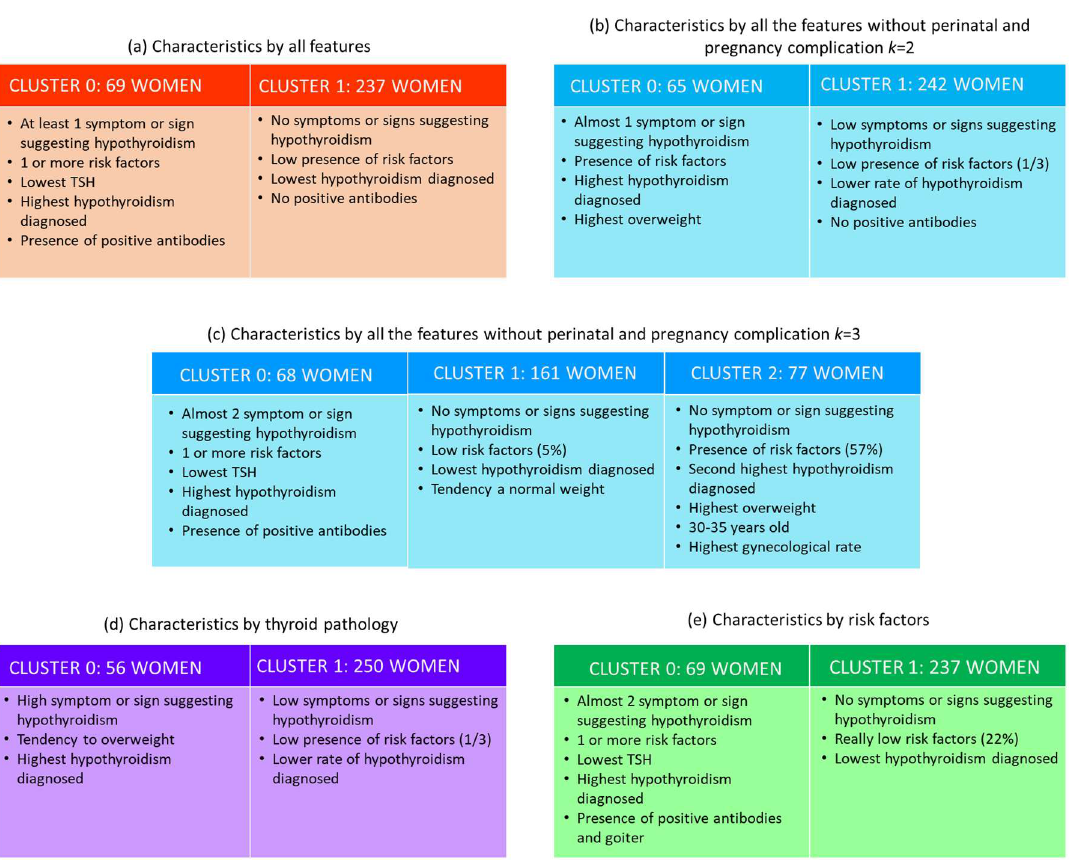
Figure 2. Cluster associations of women in first trimester of pregnancy with risk factors of thyroid